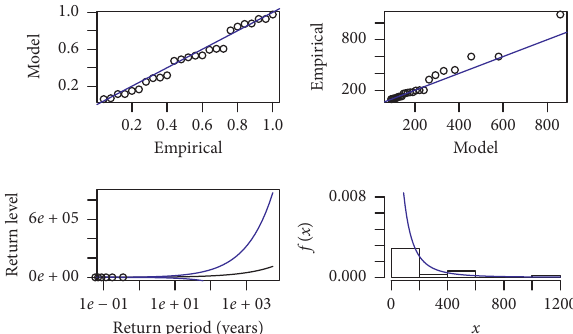
Figure 7: Diagnostic plots of deaths. (a) Probability plot. (b) Quantile plot. (c) Return level plot. (d) Density plot.